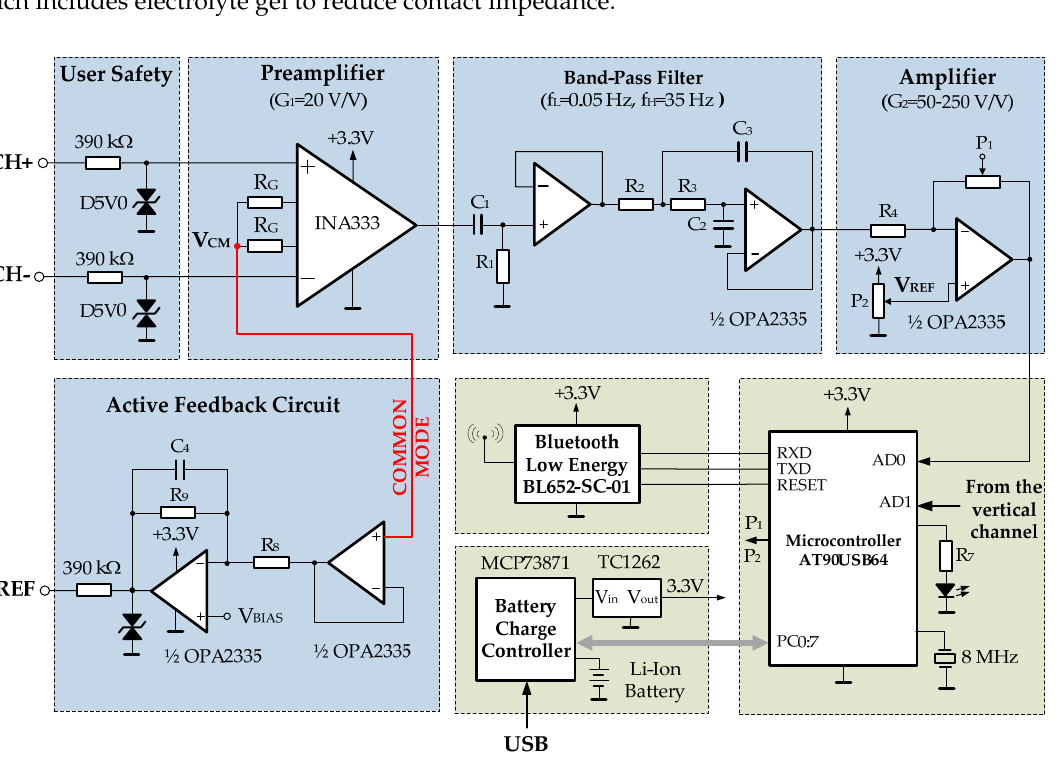
Figure 9. The electrical diagram of each channel of the developed system.